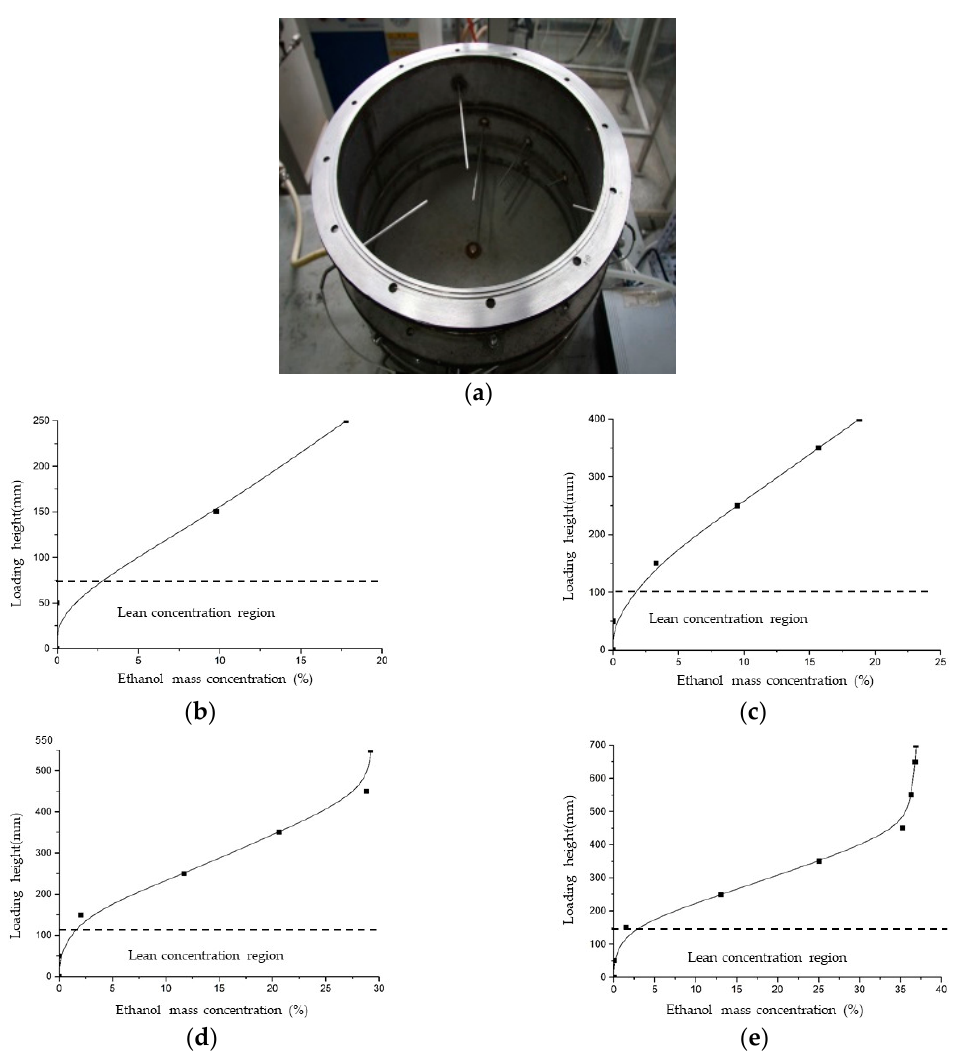
Figure 5. Ethanol concentration distribution at yielding point ( a ) photograph of thermometer location; ( b ) Ethanol concentration along 250 mm loading height ( V = 10.4 m 3 / h) at yielding point; ( c ) Ethanol concentration along 400 mm loading height ( V = 10.4 m 3 / h) at yielding point; ( d ) Ethanol concentration along 550 mm loading height ( V = 10.4 m 3 / h) at yielding point; ( e ) Ethanol concentration along 700 mm loading height ( V = 10.4 m 3 / h) at yielding point.